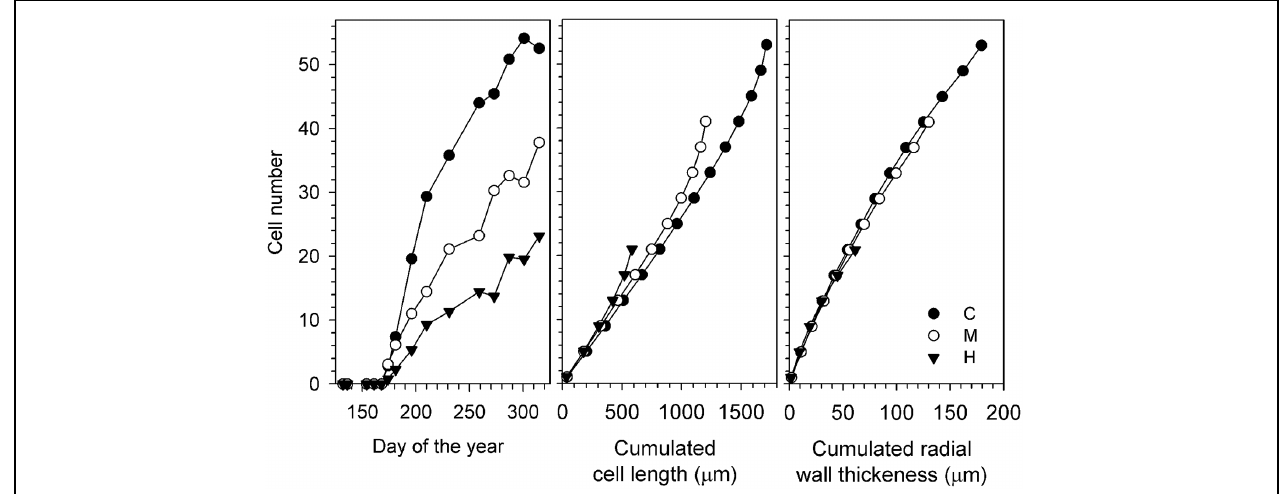
FIGURE 3 | Wood formation during the 2011 growing season for the three study sites: increase in the number of cells (Left) and anatomical component represented by cumulated cell length (Center, μ m) and cumulated radial wall thickness (Right, μ m). H, heavily defoliated trees; M, moderately defoliated trees; C, control trees.